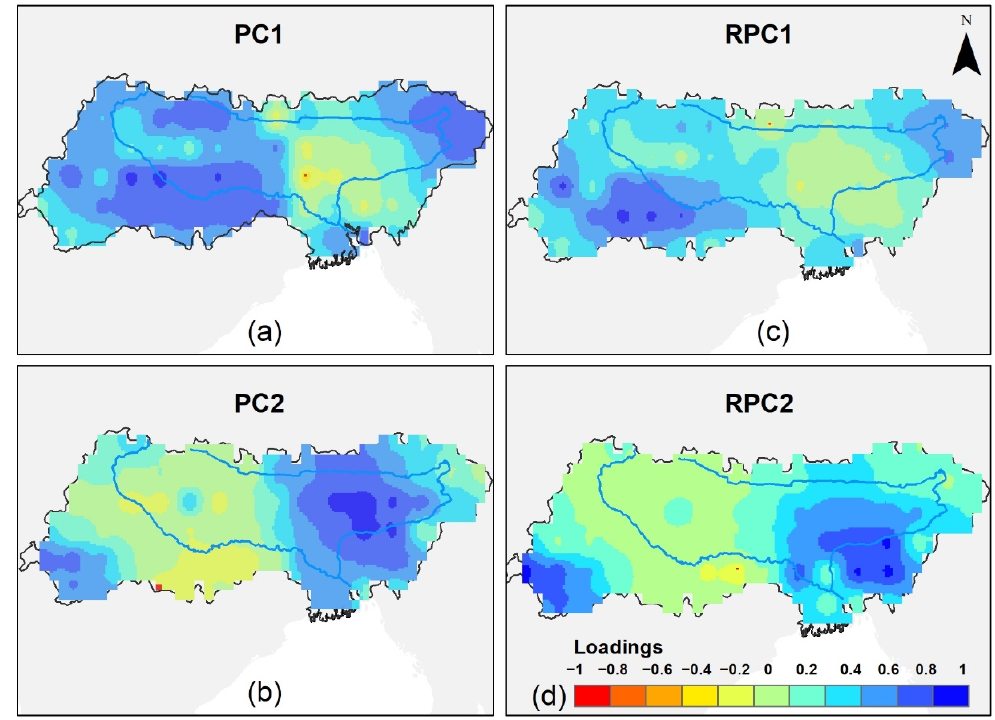
Figure 10. Loading patterns of two principal components of monsoon drought ( a , b ) and rotated loadings ( c , d ).